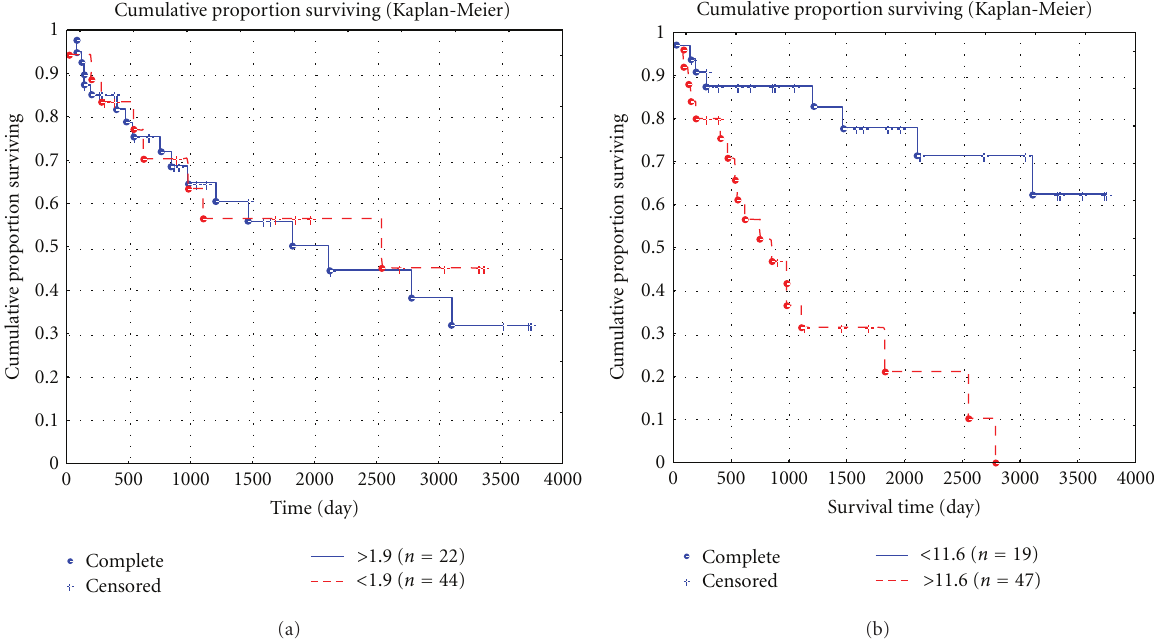
Figure 8: Cumulative proportion of 10-year survival of LMS patients, depending on the number of AgNOR proteins in peritumoral (a) and tumoral (b) endothelial cells.